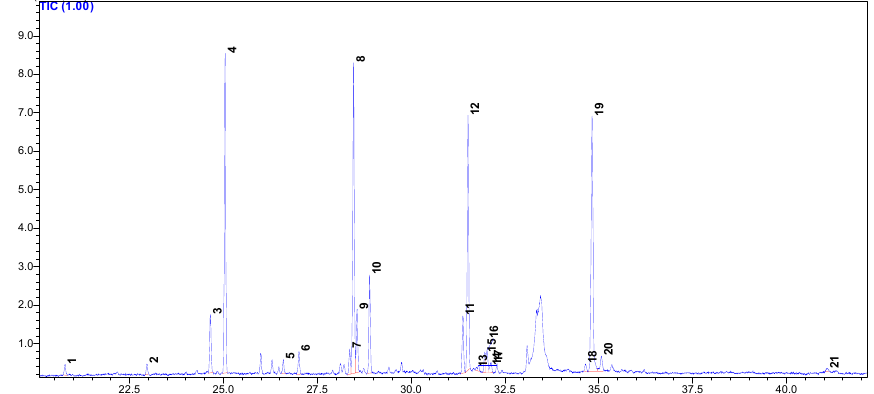
Figure A3. The representative GC-MS total ion chromatogram (TIC) profiles of fatty acid methyl esters (FAME) from Argentine red shrimp (Meat). 1. C14:0 (Myristic), 2. C15:0 (Pentadecanoic), 3.